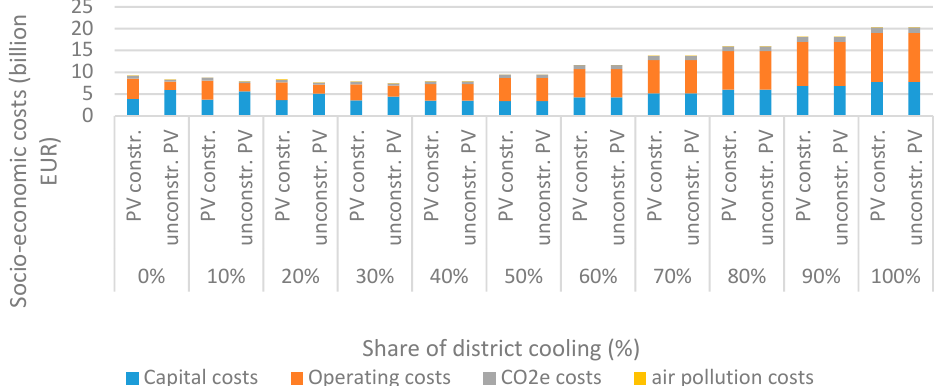
Figure 1. Comparison of the total socio-economic costs in PV constrained and unconstrained PV scenarios.